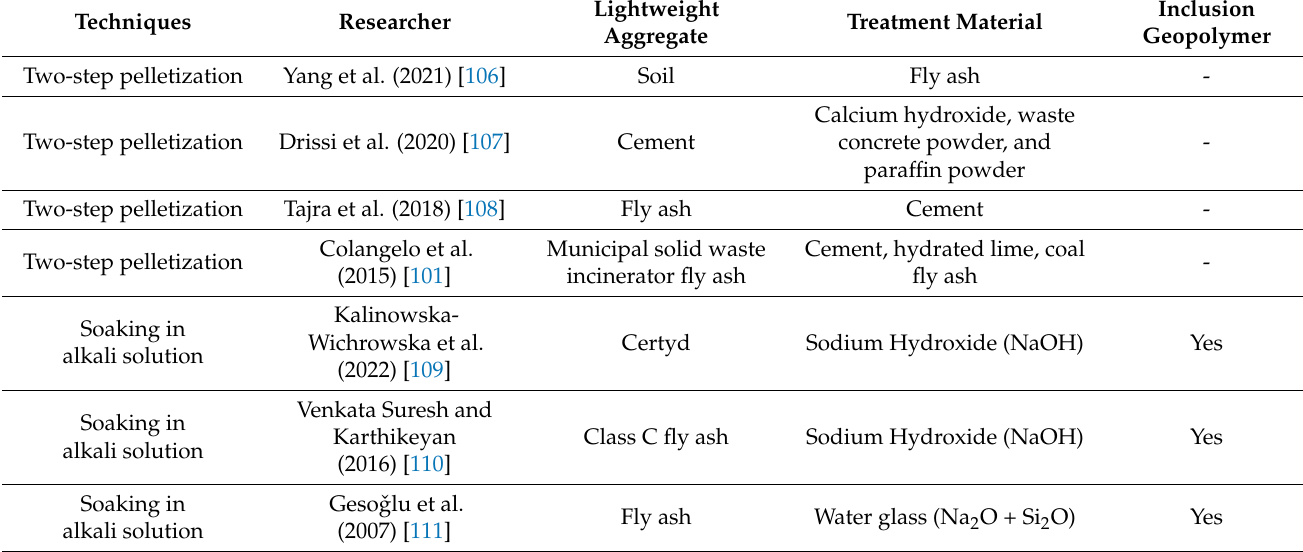
Table 5. Past research on the improvement techniques on artificial lightweight